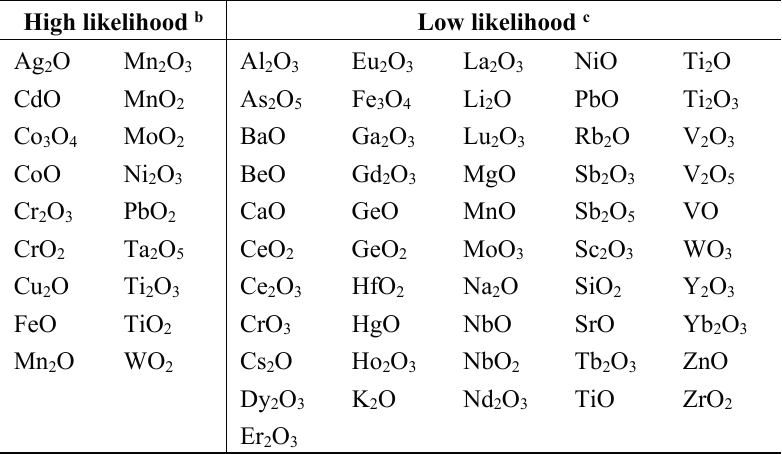
Table 1. Metal oxide nanomaterials with a high or low potential for electron transfer with biological substrates, based on the estimated energy levels of their conduction bands and valence bands [53,56]. Metal oxide potential for electron exchange with biological substrates a High likelihood b Low likelihood c Ag 2